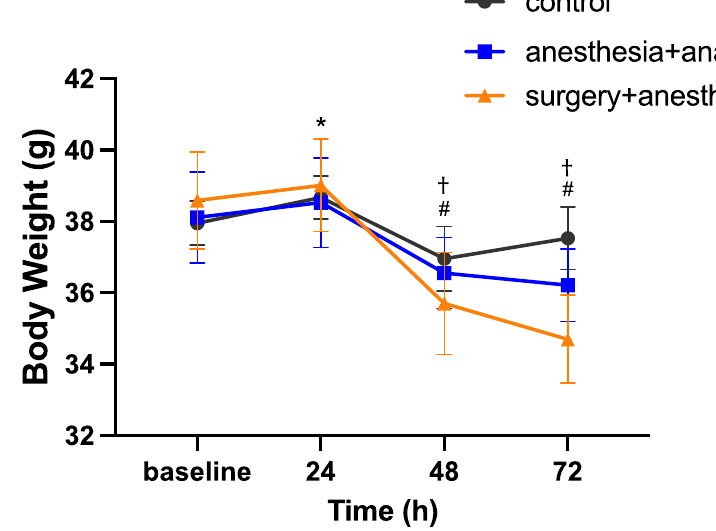
Figure 3. Comparison of postoperative changes in food intake (mean ± SE). *, value differs ( p < 0.05) between the anesthesia + analgesia and the surgery + anesthesia + analgesia groups. #, value differs ( p < 0.05) between baseline and 24, 48 h in the anesthesia + analgesia group. ##, value differs ( p < 0.05) between 24 and 72 h in the anesthesia + analgesia group. †, value differs ( p < 0.01) between baseline and 24, 48, 72 h in the surgery + anesthesia + analgesia group. ††, value differs ( p < 0.01) between 24 and 48, 72 h in the surgery + anesthesia + analgesia group. The control group: n = 7, the anesthesia + analgesia group: n = 7, the surgery + anesthesia + analgesia group: n = 7.